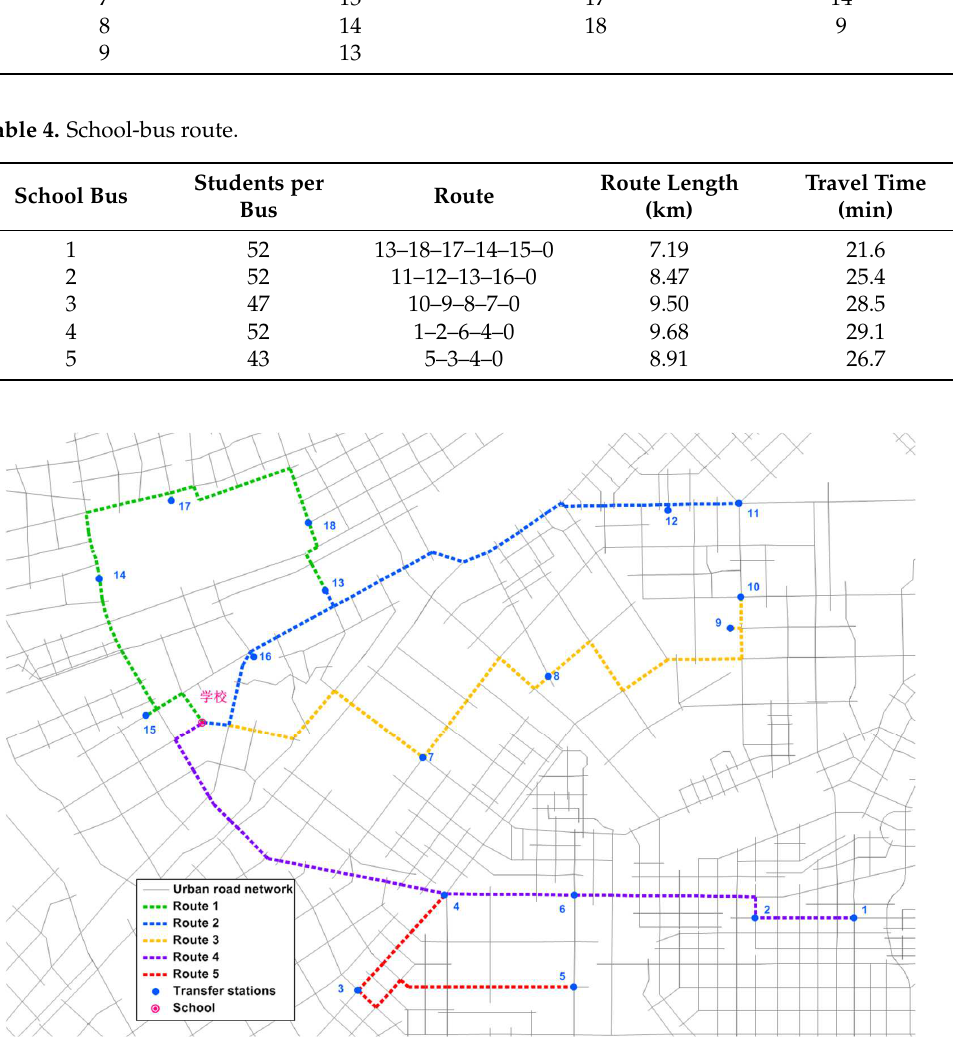
Figure 8. School-bus route.